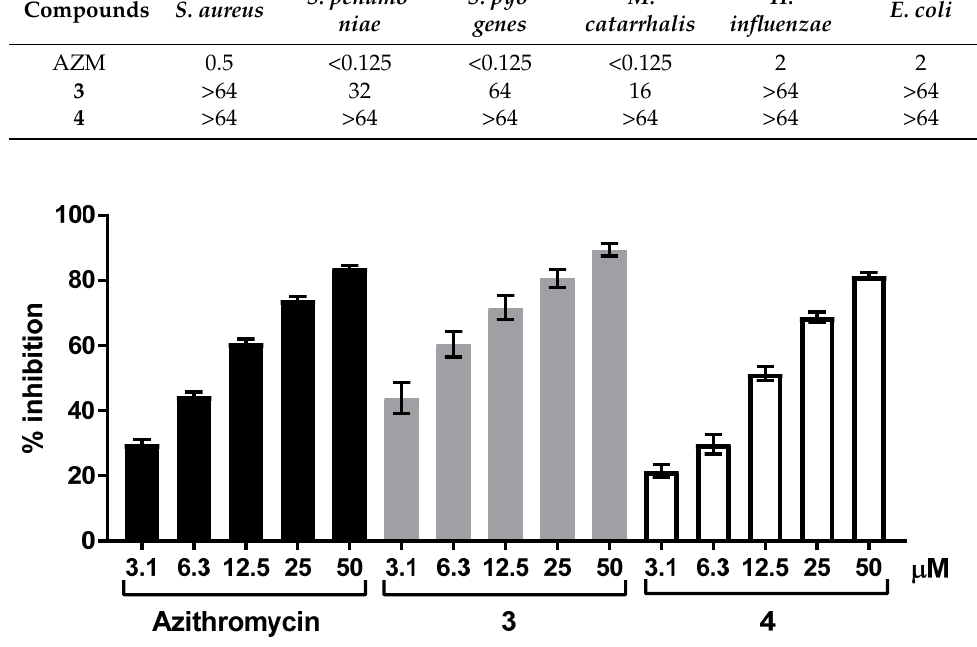
Figure 2. Inhibition of LPS-stimulated IL-6 production in murine splenocytes. Data are presented as means ± S.E.M. of 11 independent experiments for azithromycin and compound 4 and 6 experiments for compound 3 .